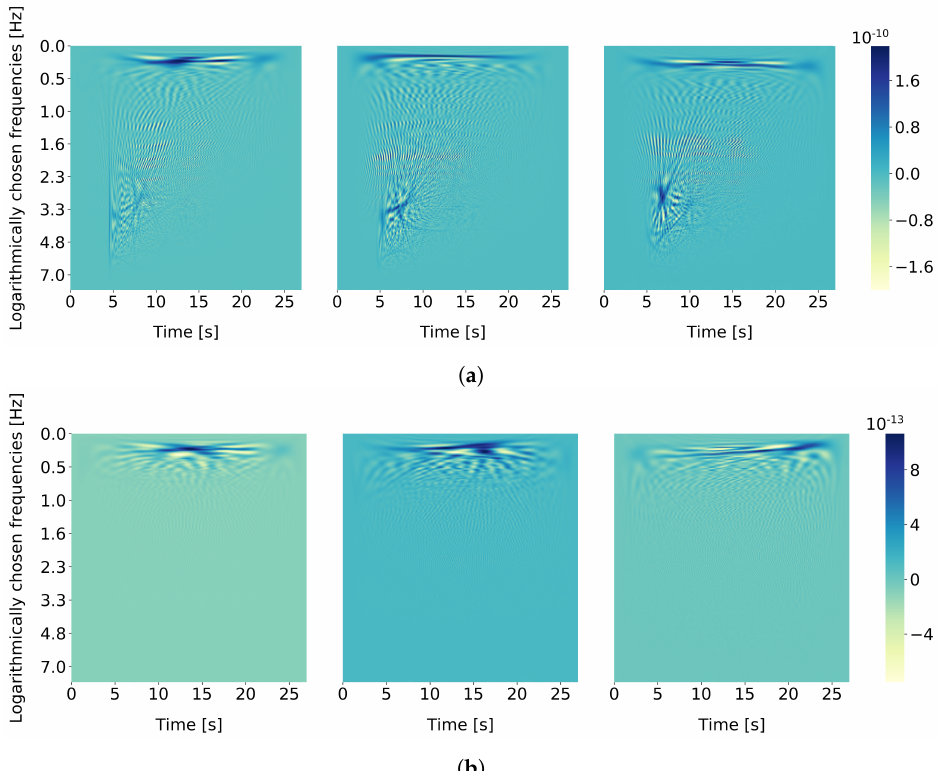
Figure 4. Wigner–Ville transformations of ( a ) an earthquake and ( b ) noise shown in Figure 2. All three axes are